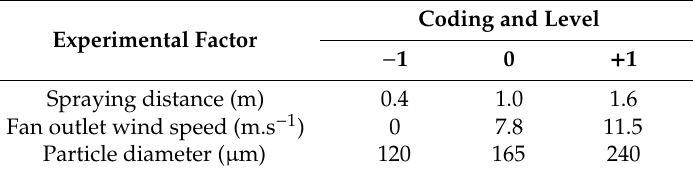
Table 7. Test factor level and